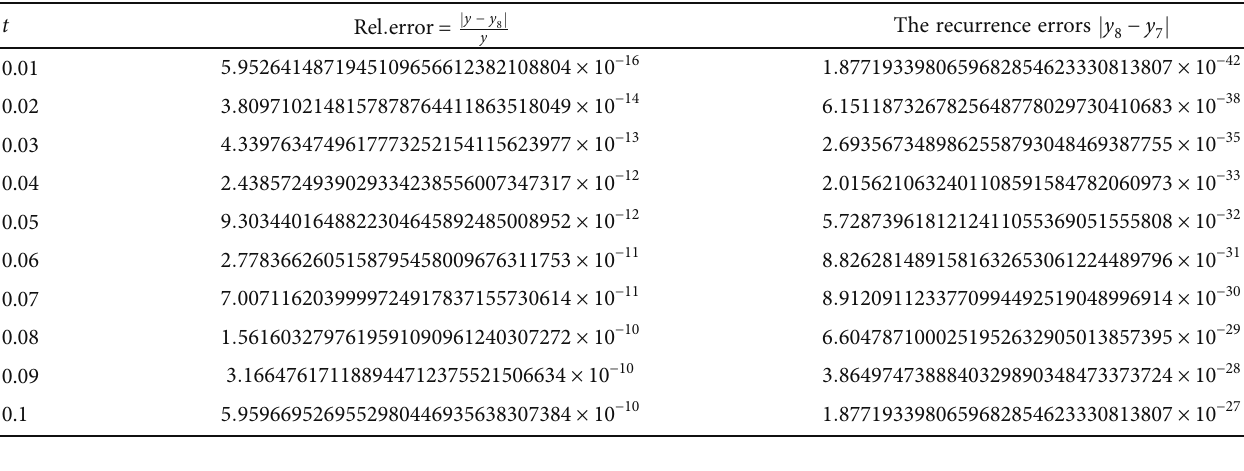
Table 8: The relative error = j y − y for Example